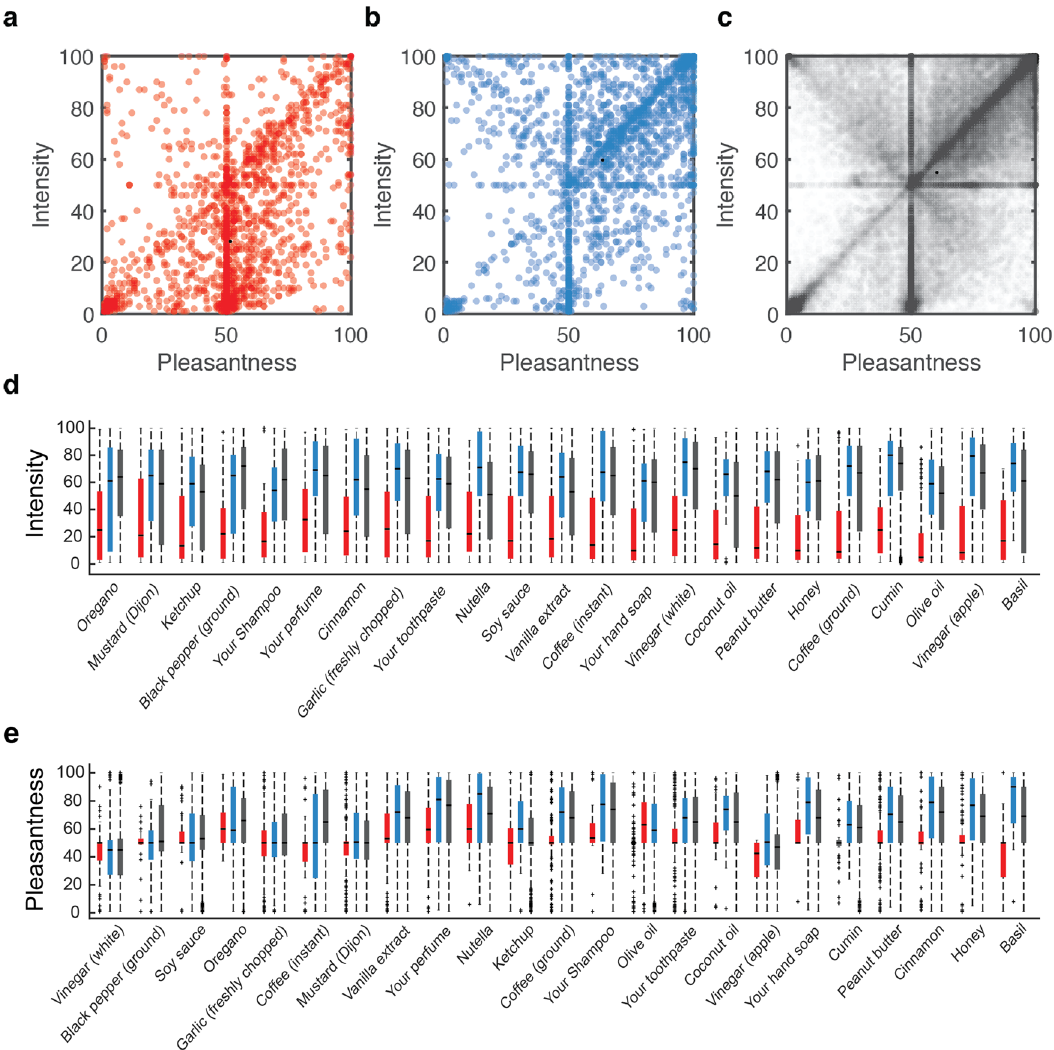
Fig. 2 Olfactory perception indicates on levels of COVID-19 infection at the population level. a – c Each dot is an odorant rating, aligned for its pleasantness and intensity estimates: a All ratings from C19 + participants ( n = 2670 ratings). b All ratings from C19 − participants ( n = 2580 ratings). c All ratings from C19-UD participants ( n = 80,500 ratings). d Intensity estimates for the 23 odorants that were each rated by at least 25 C19 + participants, ordered by effect-size from low (left) to high (right). e Pleasantness estimates for the 23 odorants that were each rated by at least 25 C19 + participants, ordered by effect-size from low (left) to high (right). C19 + in red, C19 − in blue, and C19-UD in black. d , e The central mark in the box indicates the median. Bottom and top edges of the box indicate the 25th and 75th percentiles, respectively. The whiskers extend to the most extreme data points not considered outliers. Outliers are plotted individually using the “ + ”